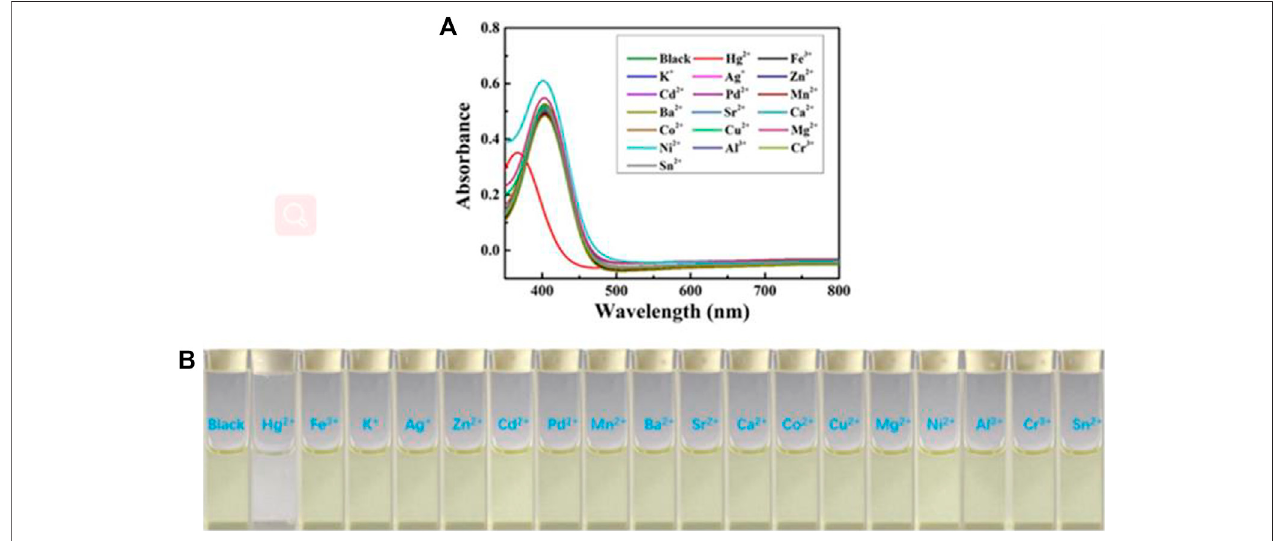
FIGURE8|(A) TheUV-Visiblespectraofchemosensor1(concentration:2.0 × 10 − 5 mol L − 1 )inacetonitrile uponadditionof10 equiv.variousmetalions. (B)